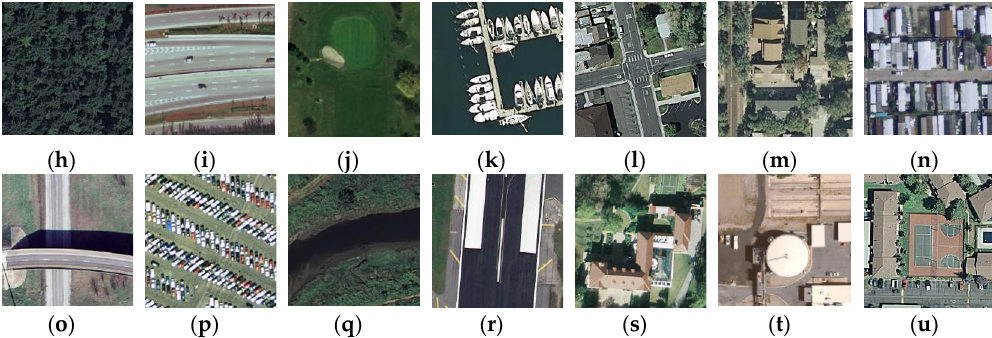
Figure 6. Image classes in UC-Merced dataset: ( a ) agriculture; ( b ) airplane; ( c ) baseball diamond; ( d ) beach; ( e ) buildings; ( f ) chaparral; ( g ) dense residential; ( h ) forest; ( i ) freeway; ( j ) golf course; ( k ) harbor; ( l ) intersection; ( m ) medium residential; ( n ) mobile home park; ( o ) overpass; ( p ) parking lot; ( q ) river; ( r ) runway; ( s ) sparse residential; ( t ) storage tanks; and ( u ) tennis court.